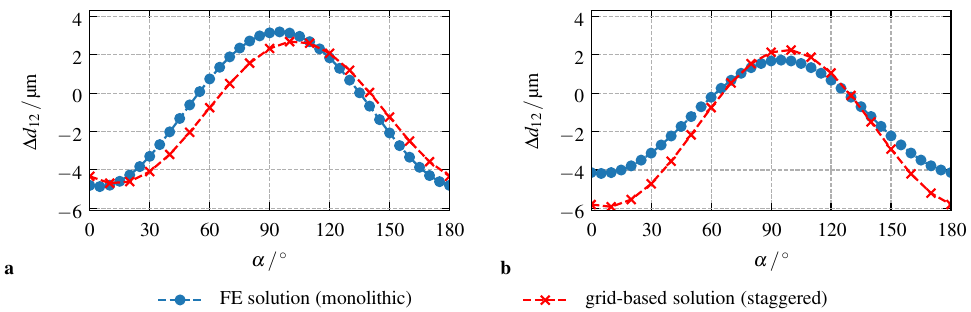
Figure 3. Comparison of the presented numerical frameworks: change of the inter-particle distance ∆ d 12 in a rotating magnetic field for ( a ) the simplified two-dimensional setup, and, ( b ) the general three-dimensional case. For both cases, the simulations have been performed using periodic BCs and a sample length l = 2mm.